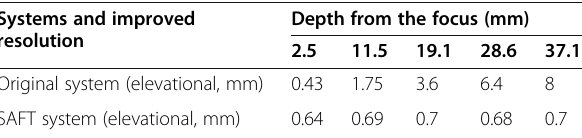
Table 1 Comparison of the elevational resolution before and after SAFT Systems and improved